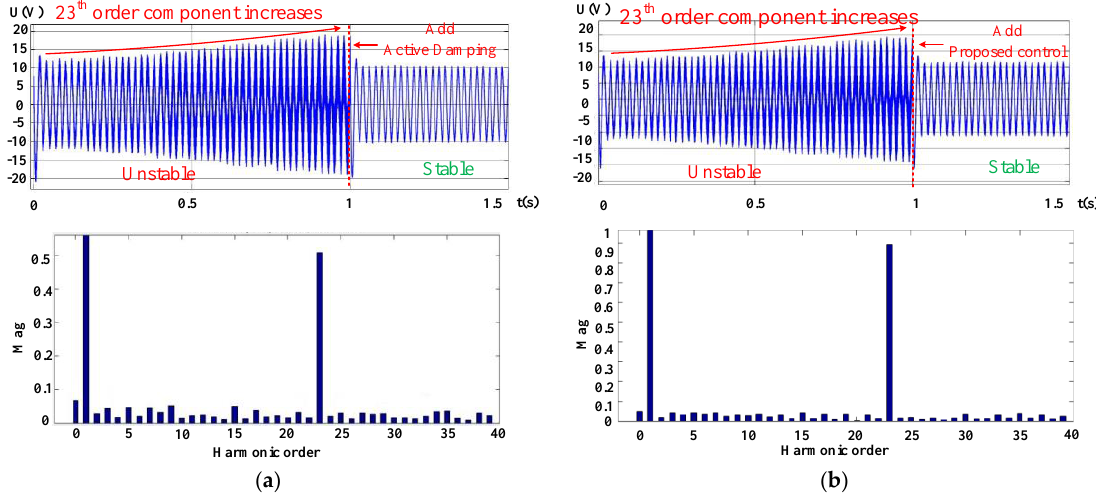
Figure 23. Output current and its THD analysis of HCGI. ( a ) Output current of HCGI and its THD analysis after t = 1 s with active damping (fundamental component = 9.73 A, 23th current component = 0.52 A, THD = 5.73%); ( b ) Output current of HCGI and its THD analysis after t = 1 s with proposed control (fundamental component = 9.686 A, 23th current component = 0.912 A, THD = 9.58%).